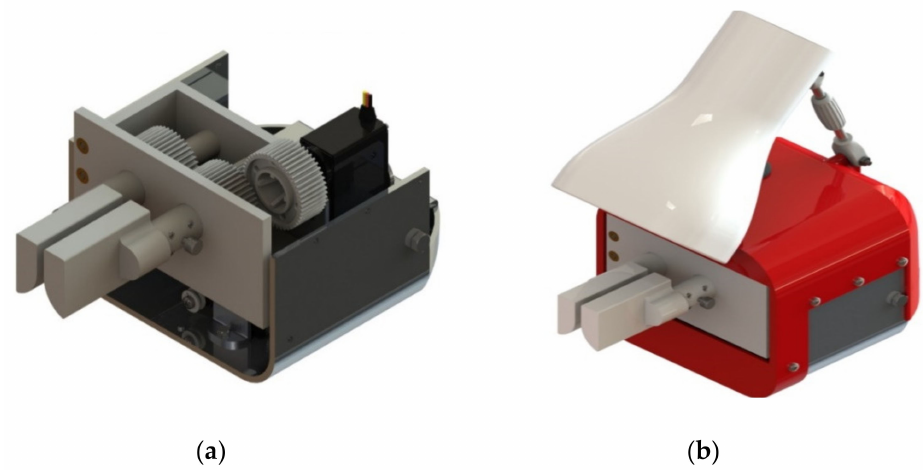
Figure 4. Assembly for end-effector: ( a ) internal part assembly; ( b ) external part